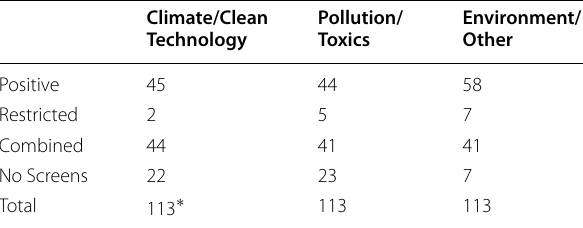
Table 5 Summary of the distribution of SRI screening strategies in our